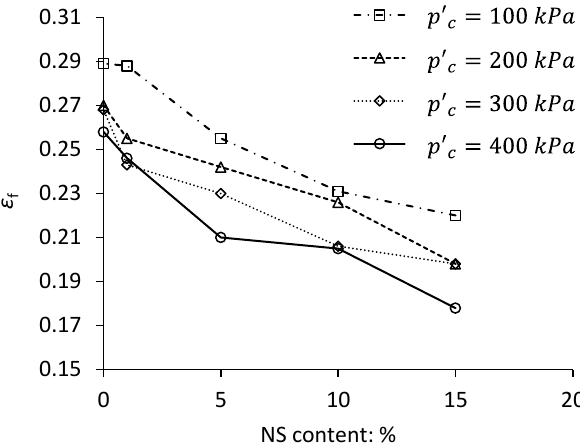
Figure 10. Variation in axial strain at peak deviatoric stress with nano-silica content.